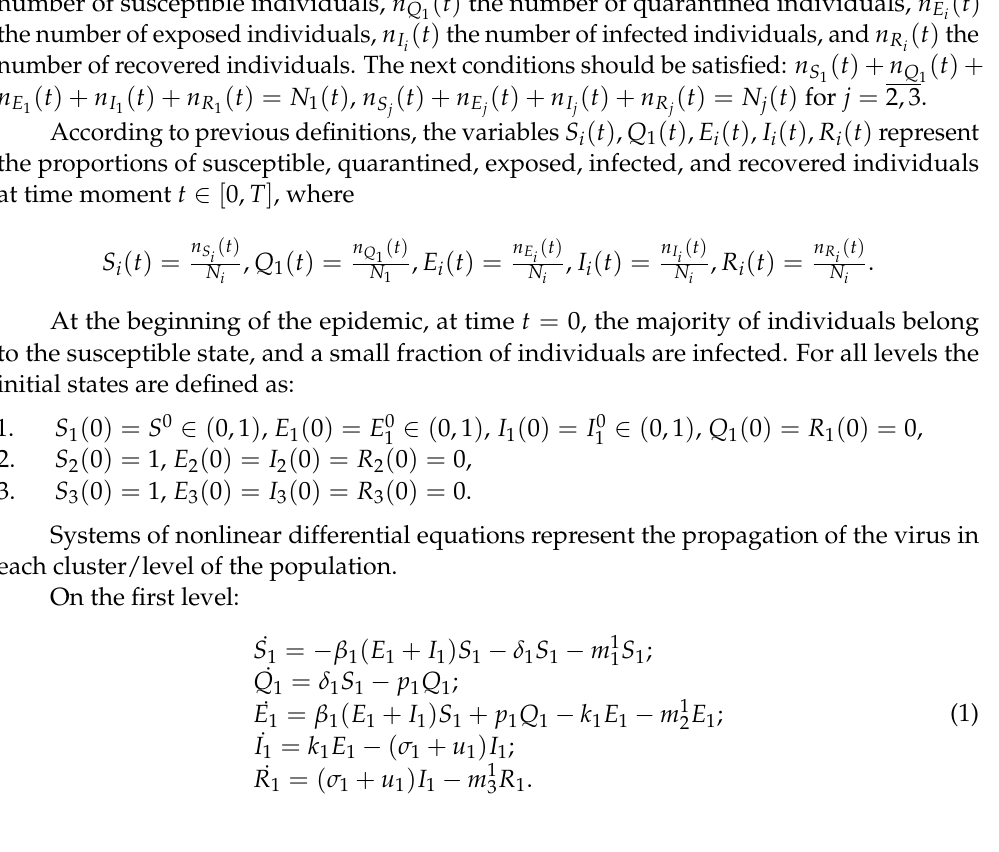
( t ) the number of quarantined individuals, n 1 ( t ) the number of infected individuals, and n i